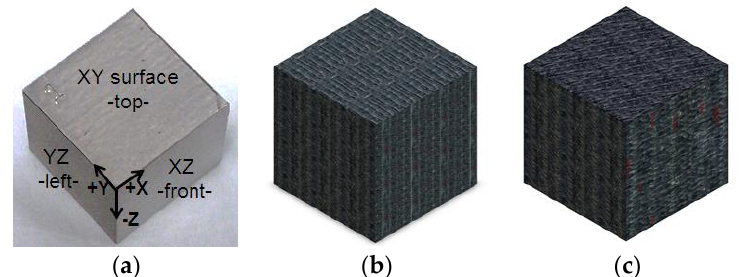
Figure 2. Faces and surfaces of the nickel alloy Inconel 625 workpiece ( a ) and illustration of directionality in 90° ( b ) and 67° ( c ) scan strategy rotation on the workpiece.